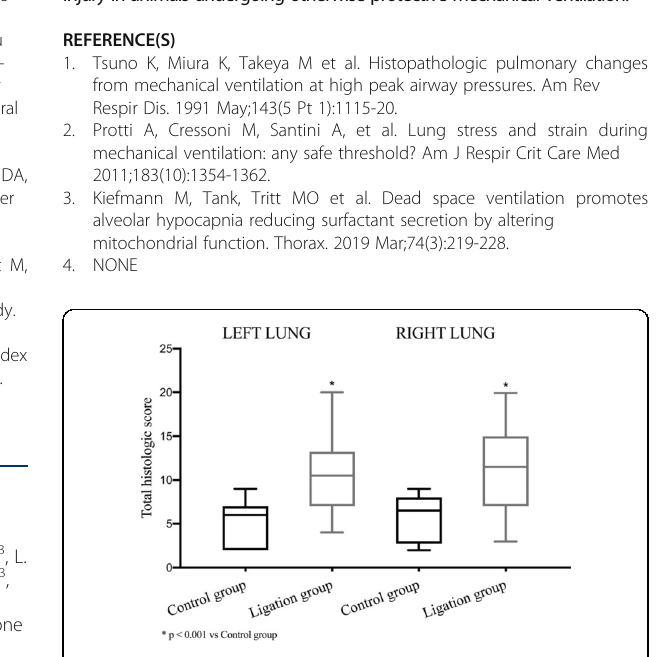
Fig. 1 (abstract 001099). Total histologic score between groups